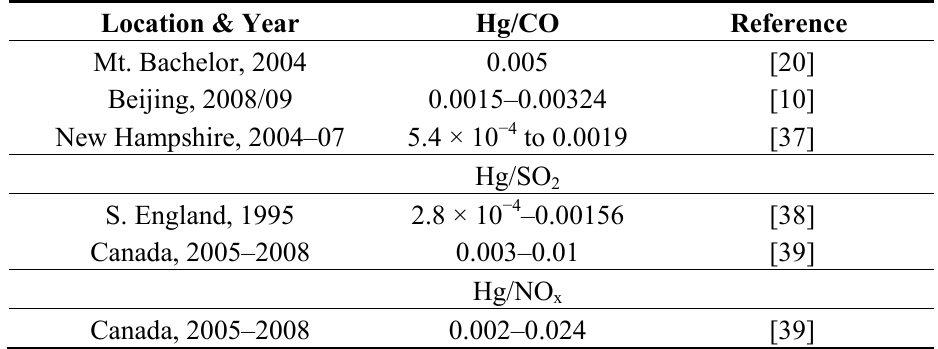
Table 2. Slope values of Total Gaseous Mercury or Gaseous Elemental Mercury (TGM/GEM) correlations from other studies and years all in the format ng ∙m − 3 ppbv − 1